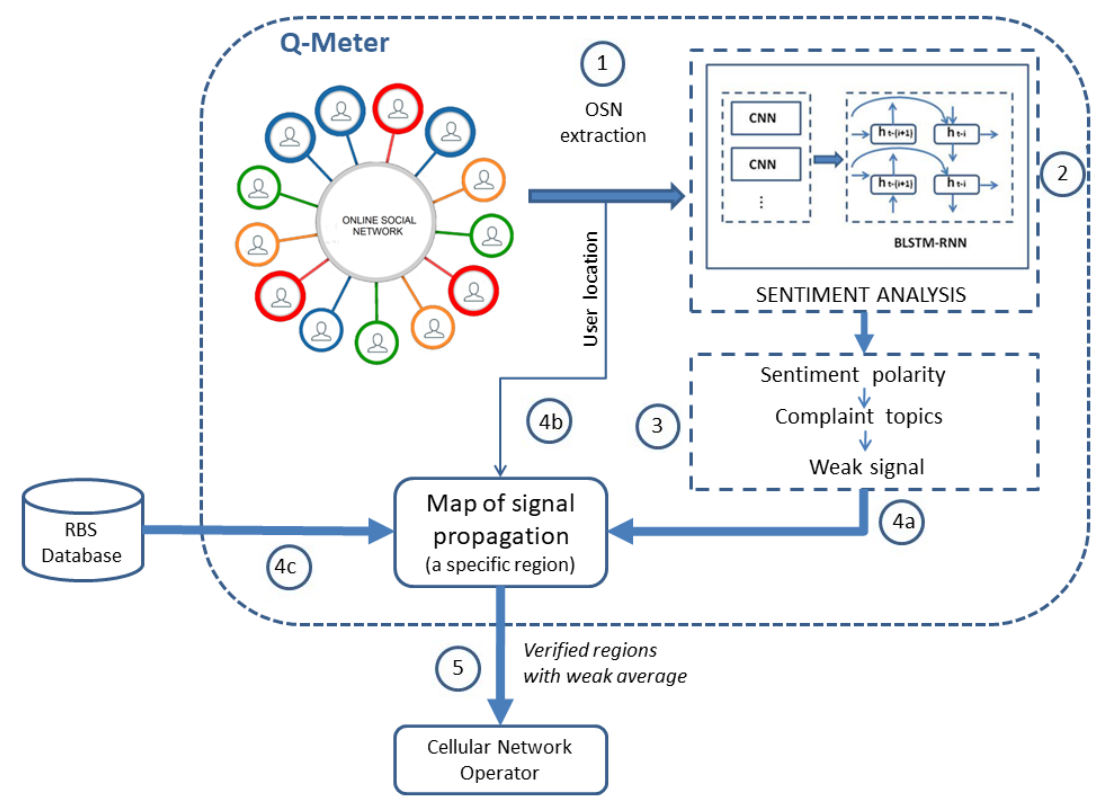
Figure 1. Steps for performing the proposed system named